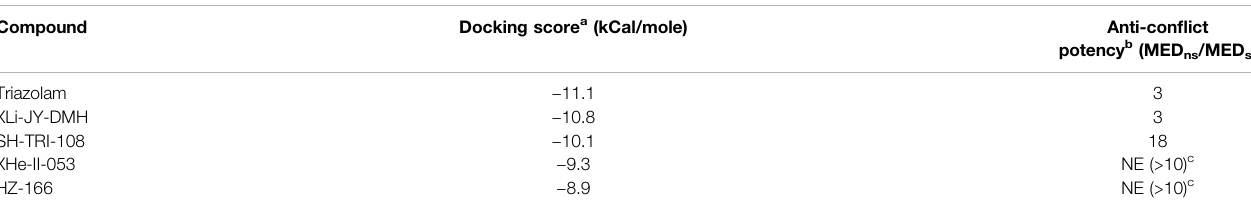
TABLE 7 | Binding energy ( α 1GABA A subtype) estimated by autodock vina, compared with anti-con fl ict potency.